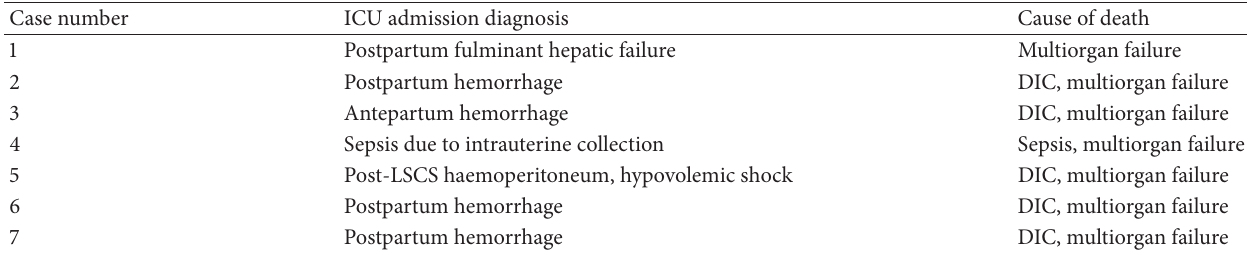
Table 5: Maternal